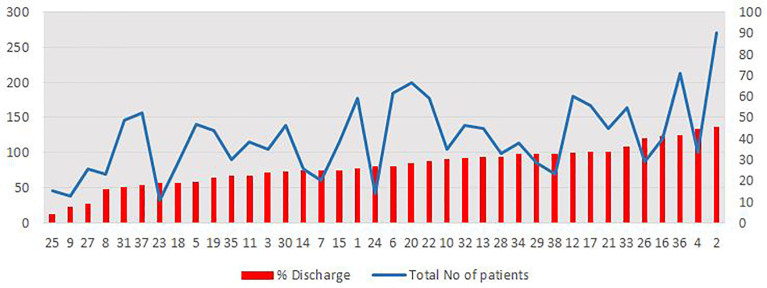
Summary of total patients with chest pain (left vertical axis) who were seen and percent discharged (right vertical axis) by physician. Each red bar and blue dot pair represents an individual physician (n=38).